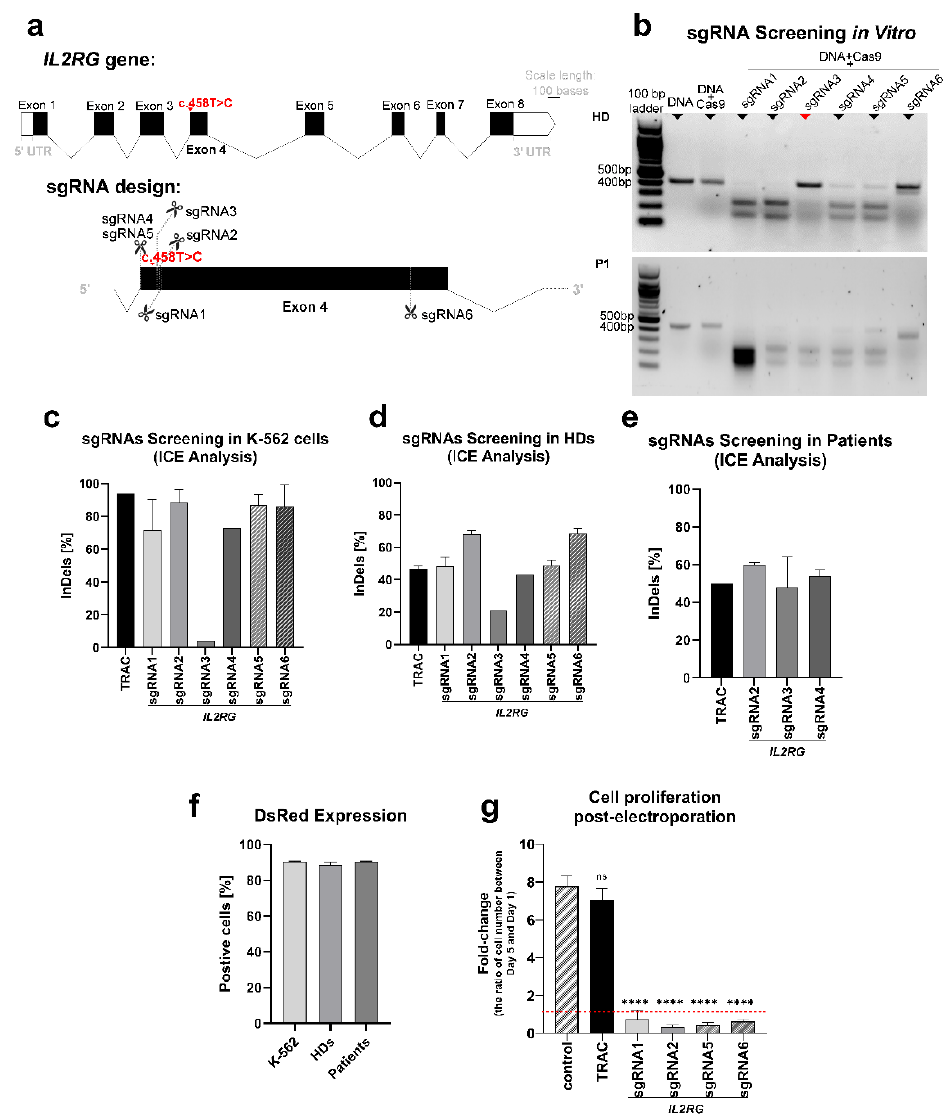
Figure 2. Design and screening of sgRNAs. ( a ) Schematic representations of the IL2RG gene and designed sgRNAs were created in the Exon-Intron Graphic Maker (http://wormweb.org/exonintron) and modified in PowerPoint. the IL2RG gene’s eight exons are depicted: the c.458T>C mutation is presented on Exon4. The cutting sites of all designed sgRNAs are highlighted. sgRNA1 and 5 target the wild-type sequence; sgRNA3 and 4 target the mutant sequence; and sgRNA2 and 6 target both sequences. ( b ) In vitro CRISPR/Cas9 cutting assay. The visualization of the agarose gel showed that the PCR products (409 bp) were cut into fragments of different sizes after RNP incubation for 2 h (bands with 246 bp and 163 bp for sgRNA1; 251 bp and 158 bp for sgRNA2; 250 bp and 159 bp for sgRNA3; 243 bp and 166 bp for sgRNA4; 243 bp and 166 bp for sgRNA5; 364 bp and 45 bp for sgRNA6). sgRNA1, 2, 4, 5, and 6 similarly cut the target DNA amplicon of both the healthy donor (HD) and P1, while sgRNA3 only worked for the DNA of P1. ( c ) sgRNA screening of K–562 cells (n = 2). All sgRNAs led to a more than 70% indel frequency, except sgRNA3 (4%). ( d ) sgRNA screening of T cells in healthy donors (n = 3). sgRNA3 generated a 21% indel rate, whereas the rest of the sgRNAs generated a more than 60% indel rate. ( e ) sgRNA screening of T cells in patients (n = 2, P1 and P2). sgRNAs induced a 32–64% indel formation. ( f ) DsRed protein expression was detected 24 h post-transfection with flow cytometry as 90% in K – 562 and T cells. ( g ) The proliferation rate of transfected T cells (healthy donors, n = 3) is calculated according to the fold-change (ratio) of the cell number between day 5 and day 1 post-electroporation. Compared with non-transfected cells, the proliferation rate was reduced significantly in cells transfected with IL2RG sgRNAs and Cas9 (****, p < 0.0001; ordinary one-way ANOVA test) but not in cells transfected with TRAC sgRNA and Cas9